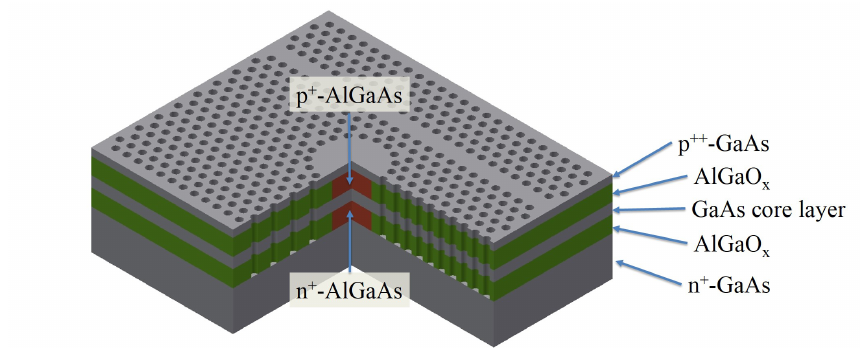
Figure 1. Schematic of electrically-driven CirD